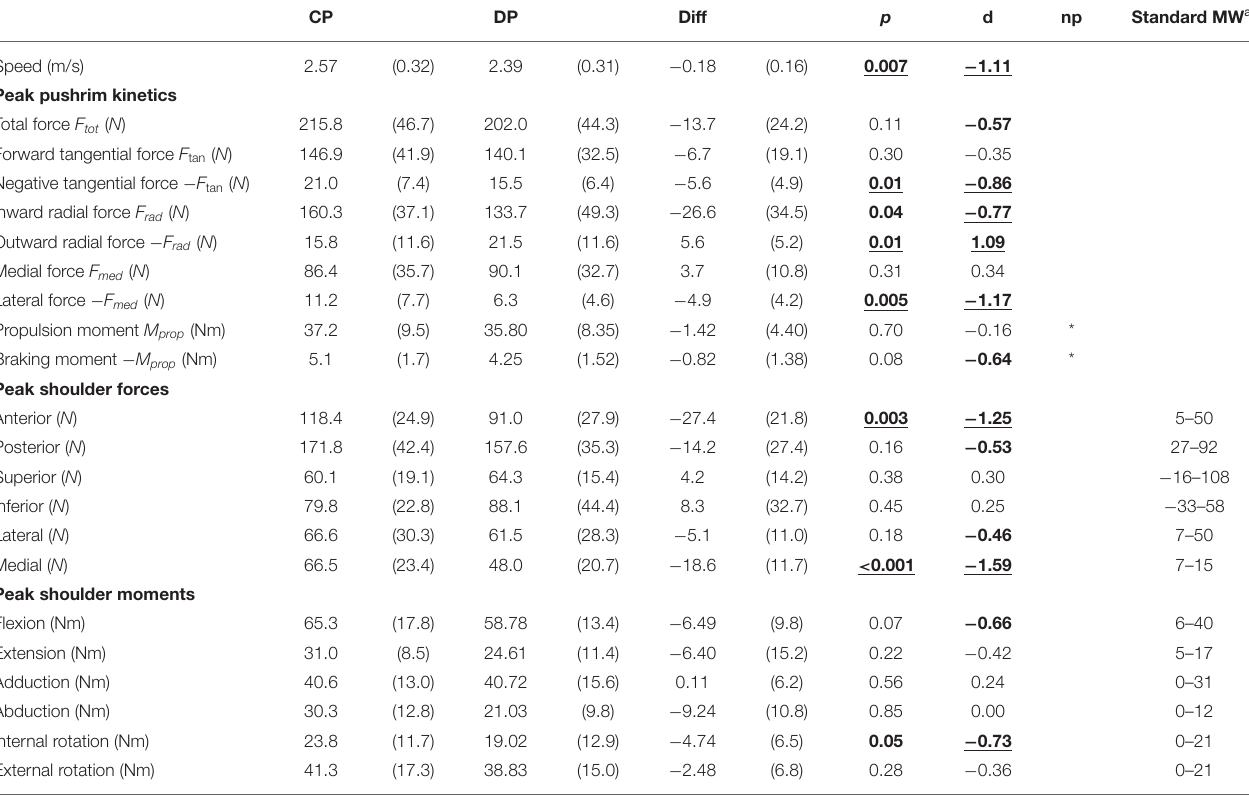
TABLE 2 | Comparison of outcome measures between both conditions. CP DP Diff p d np Standard MW a